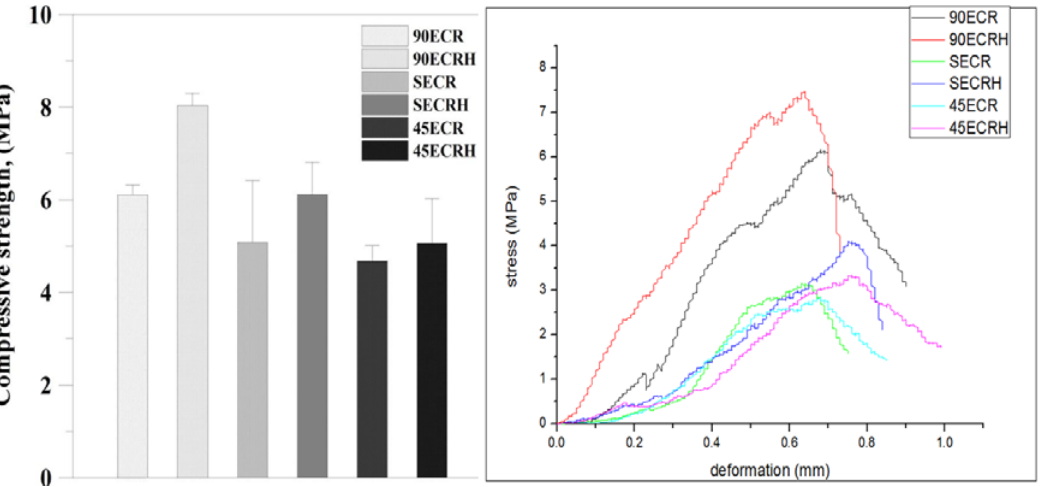
Figure 6. Compressive strength of each structure of scaffolds (three groups of samples were tested).